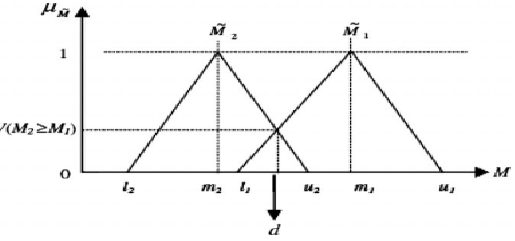
and (cid:1839) (cid:2869) (cid:2870)